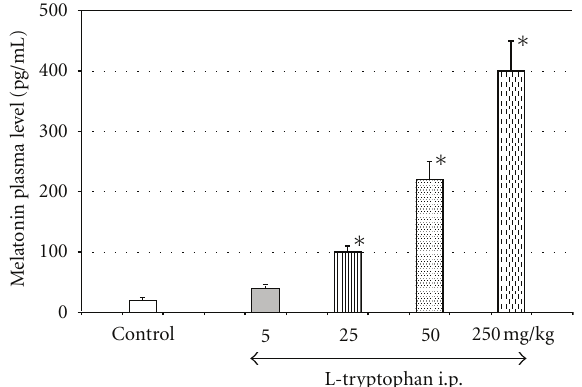
Figure 3: Plasma level of melatonin in response to intraperitoneal (i.p.) administration of increasing doses of L-tryptophan. Mela- tonin plasma level was measured by RIA. Means ± SEM from the separate experiments, each performed on 8–10 rats. Asterisk indicates significant increase above the control